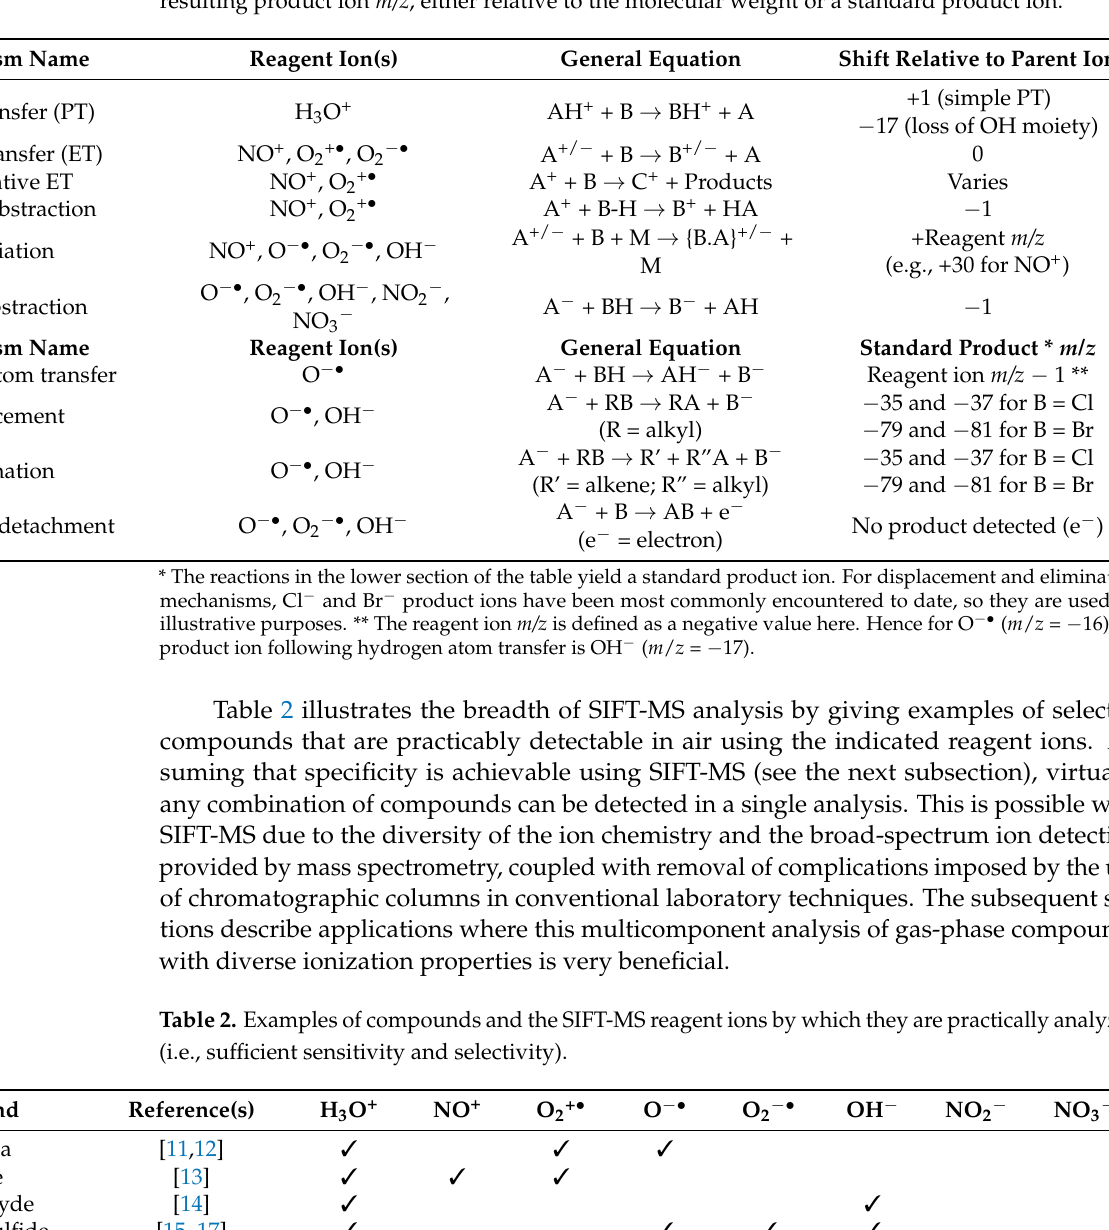
Table 1. The most common ion–molecule reaction mechanisms of the SIFT-MS reagent ions and the resulting product ion m/z , either relative to the molecular weight or a standard product ion.